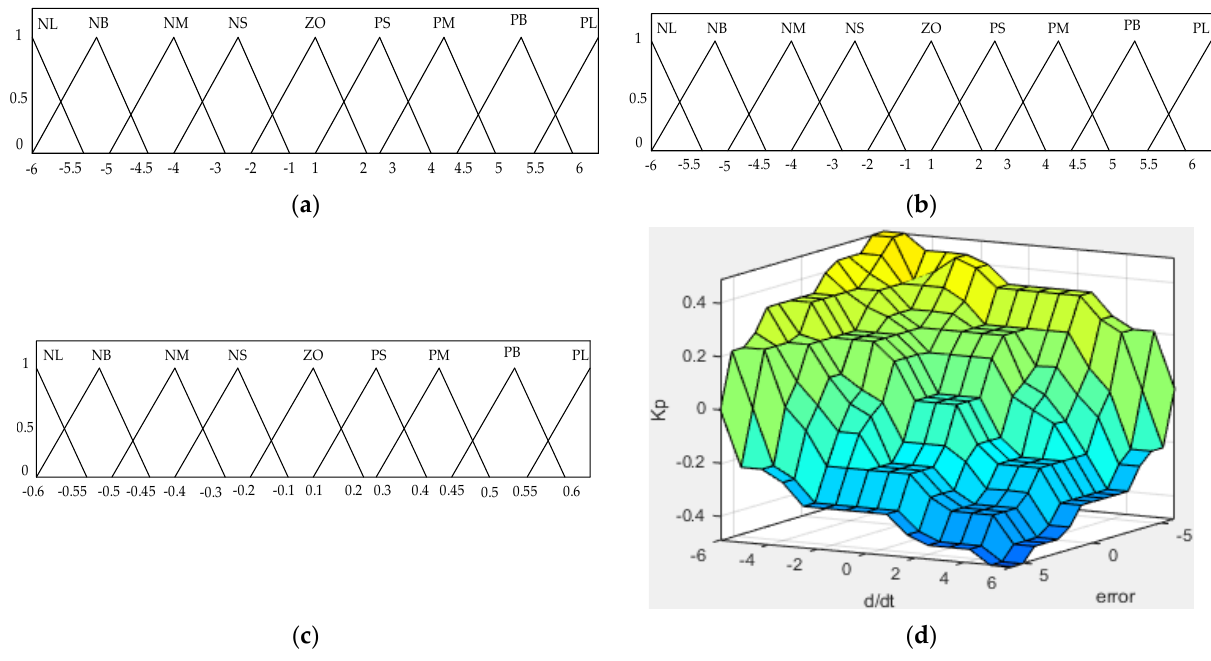
Figure 3. The input – output membership and output surface for a fuzzy control system ( a ) the membership function of the input VDC error control; ( b ) the membership function of the fuzzy controlled change ( 𝑑 ) input; ( c ) the membership function of the fuzzy controlled errors; and ( d ) the membership function rules of the fuzzy control output 3D surface view.